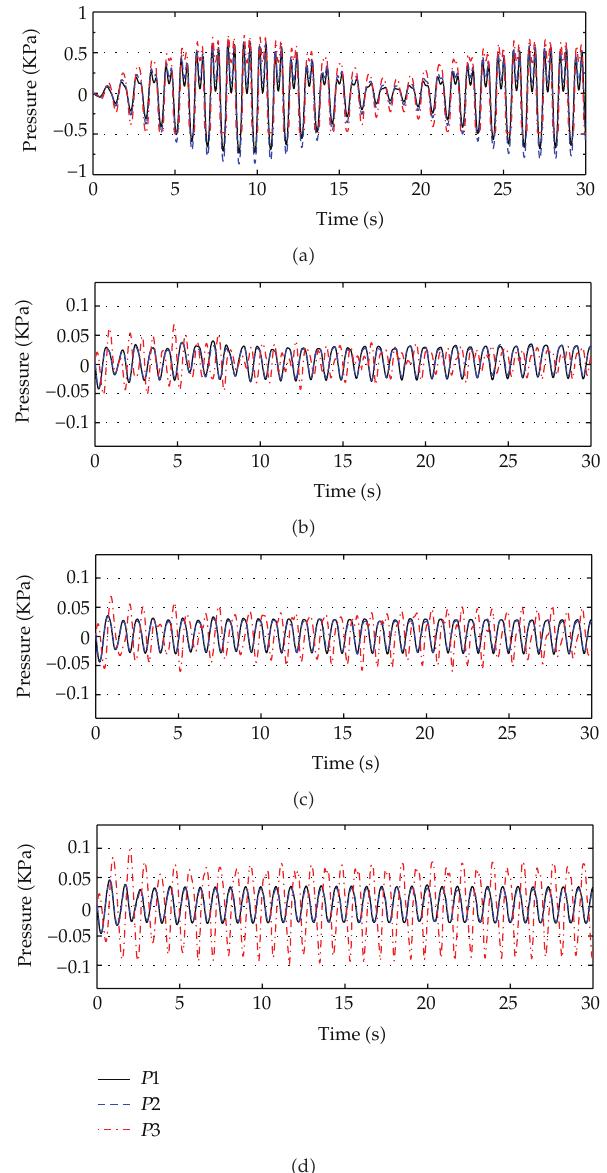
Figure 13: Dynamic pressure acting on the sidewall normal to the motion of the tank (cid:6)(cid:6) a (cid:7) without ba ffl e; (cid:6) b (cid:7) b (cid:9) 0mm; (cid:6) c (cid:7) b (cid:9) 40mm; (cid:6) d (cid:7) b (cid:9) 80mm (cid:7) .